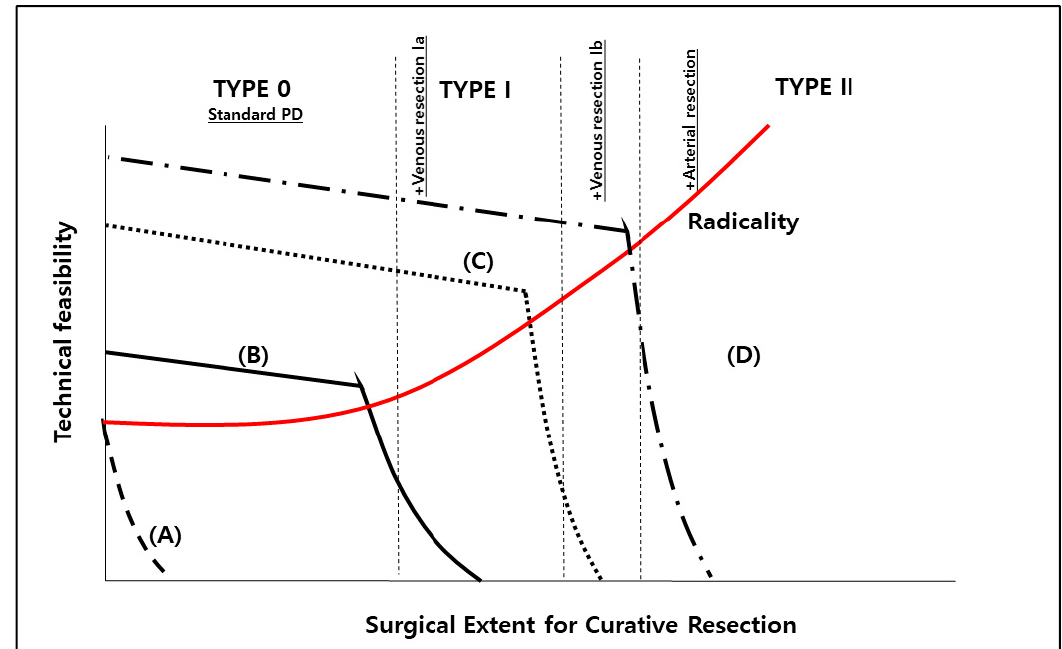
Figure 4. Model for determining surgical indication of LPD for pancreatic cancer. Regardless